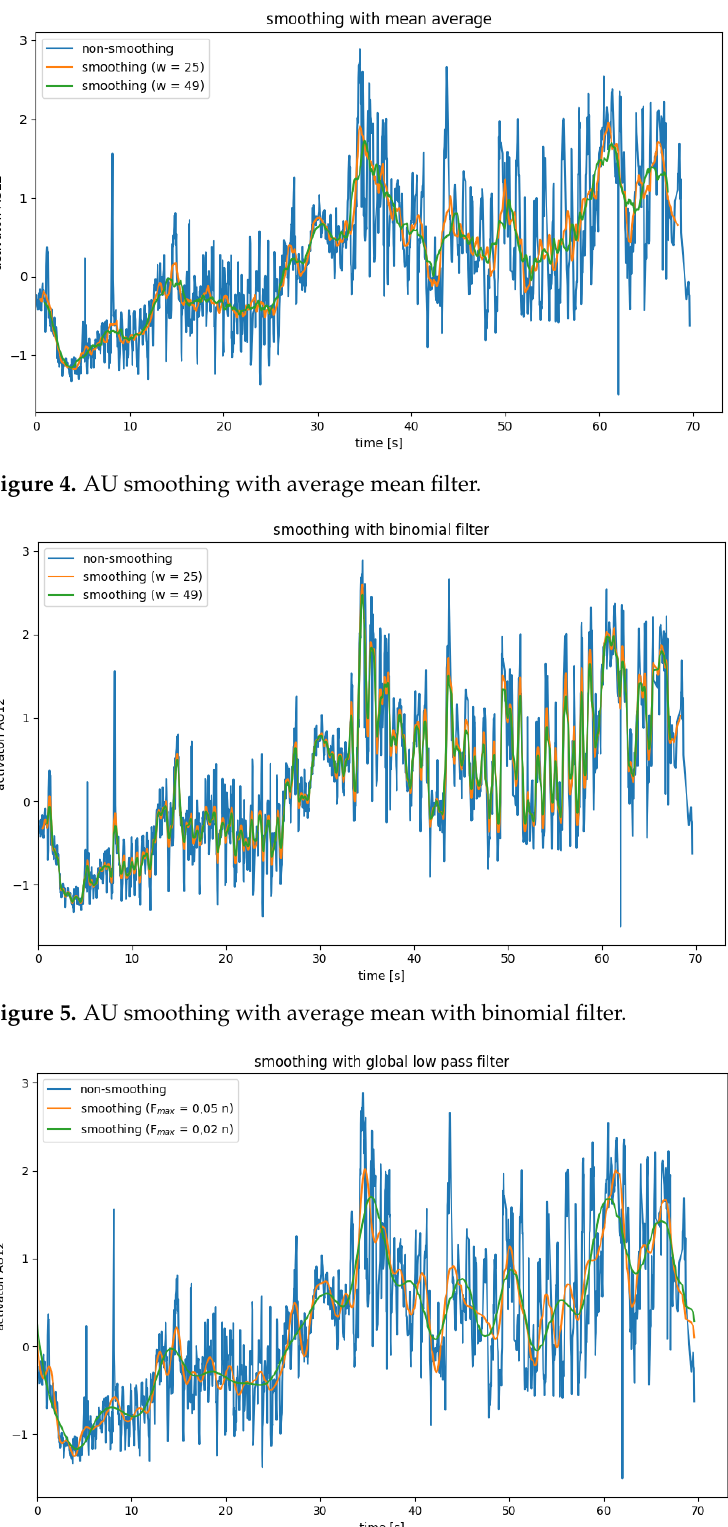
Figure 6. AU smoothing with average mean with a global low pass